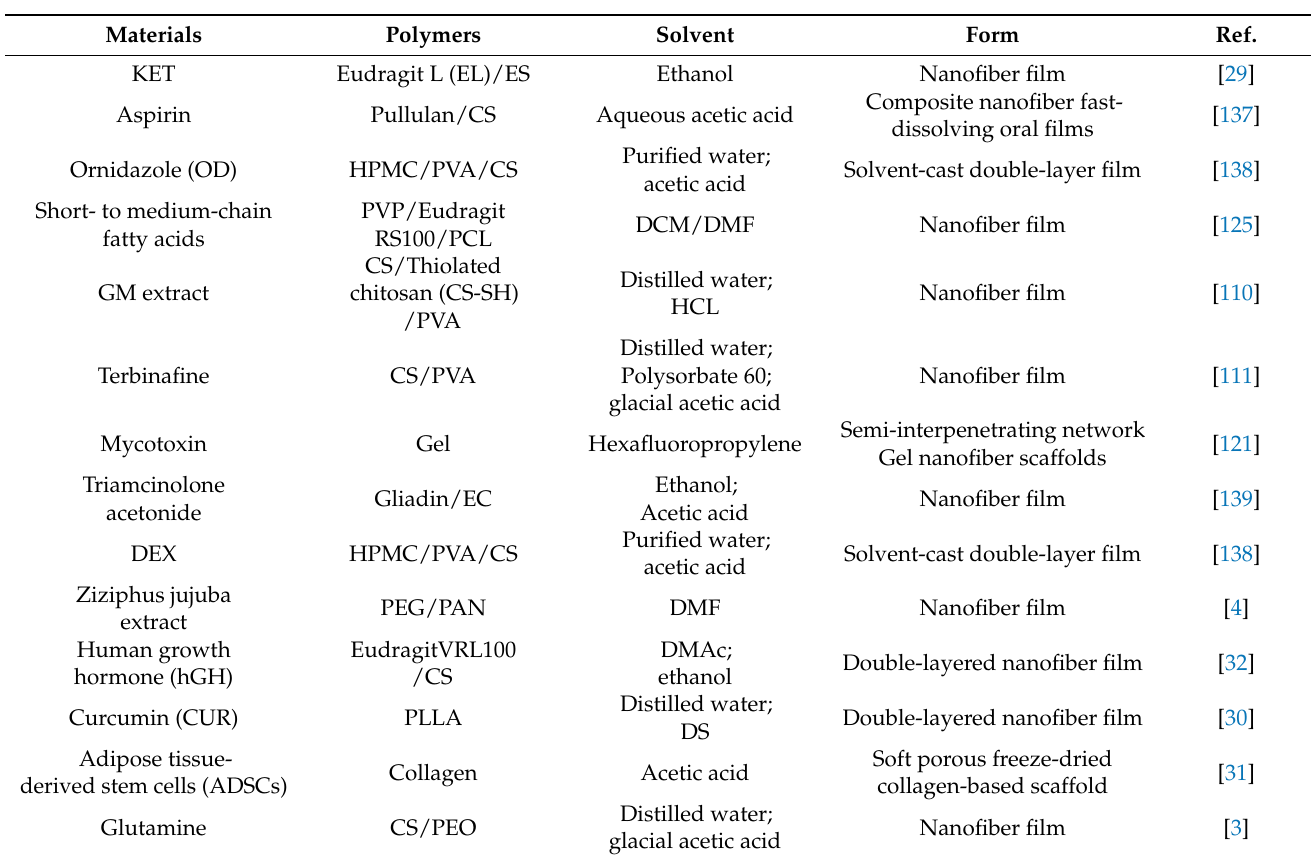
Table 3. Ingredients used in the treatment of oral